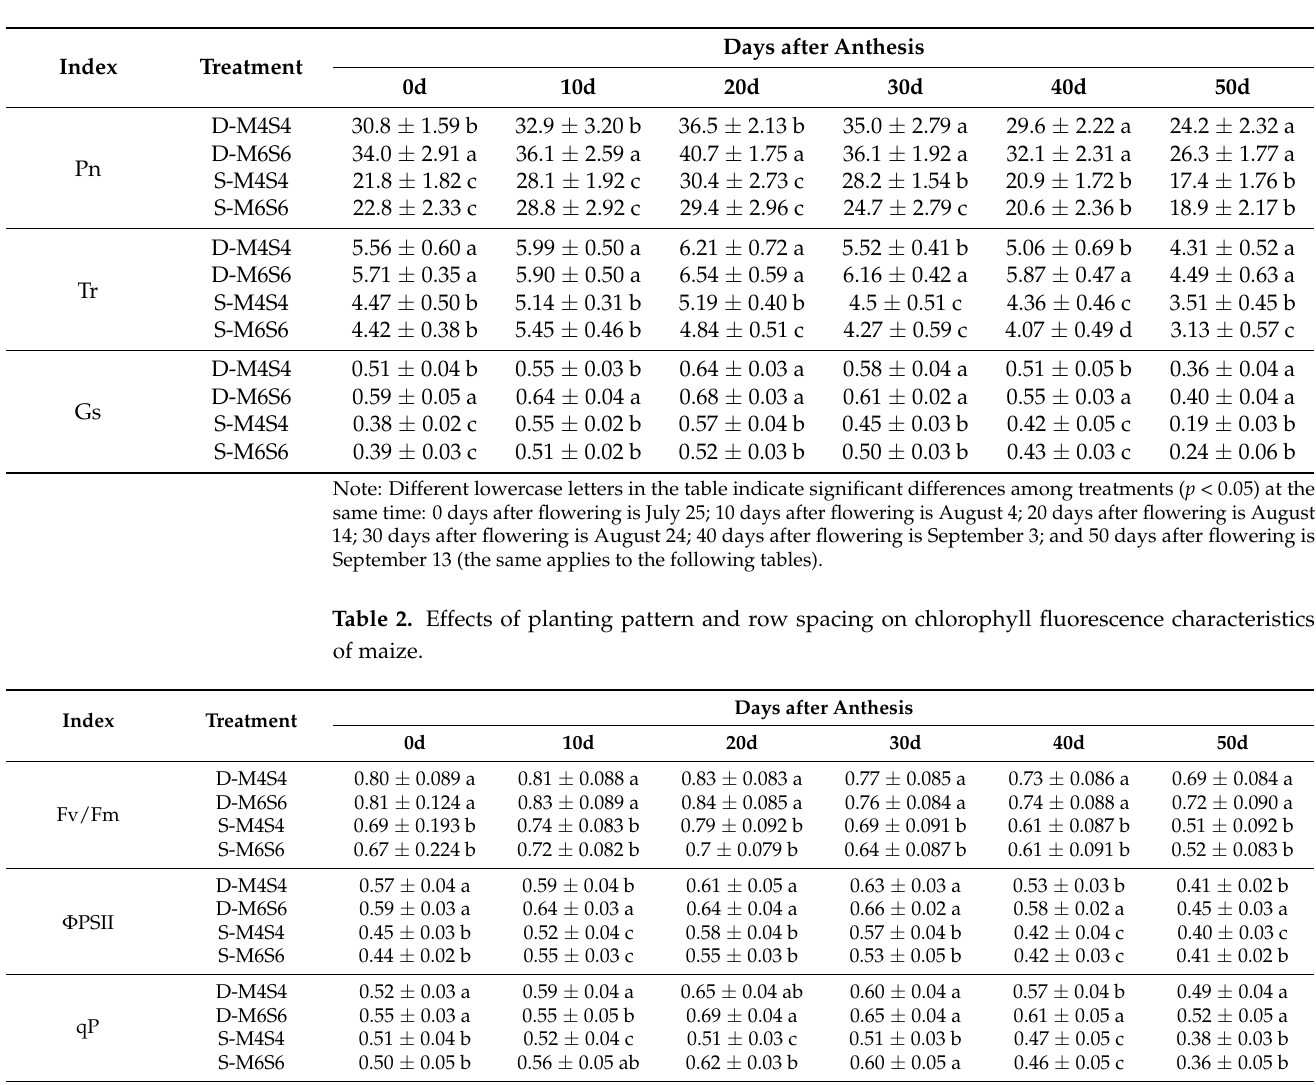
Table 1. Effects of planting pattern and row spacing on the photosynthetic characteristics of maize ear leaves.